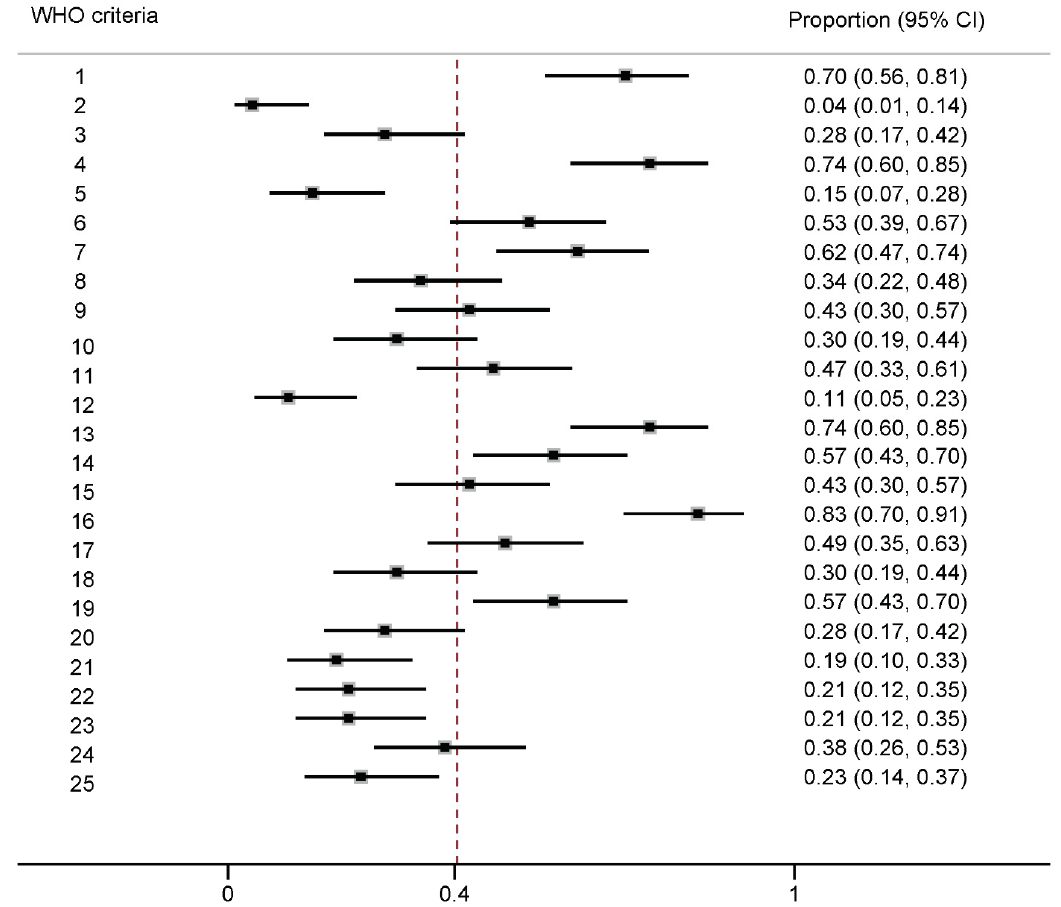
Figure 2. Estimated proportion (95% confidence interval) of guidelines that fulfilled each of the 25 WHO methodological criteria 1 for guideline development. 1 WHO methodological criteria [20]: 1. Discipline representation; 2. Diversity representation; 3. Stakeholder input; 4. Disclosure of conflicts of interest obtained; 5. Conflicts of interest managed; 6. Disclosure of funders of the guideline obtained and disclose funder’s role in influencing the guideline development recommendations; 7. Formulation of key questions for the evidence review in PICO, PICOT, or PEO format; 8. Choosing